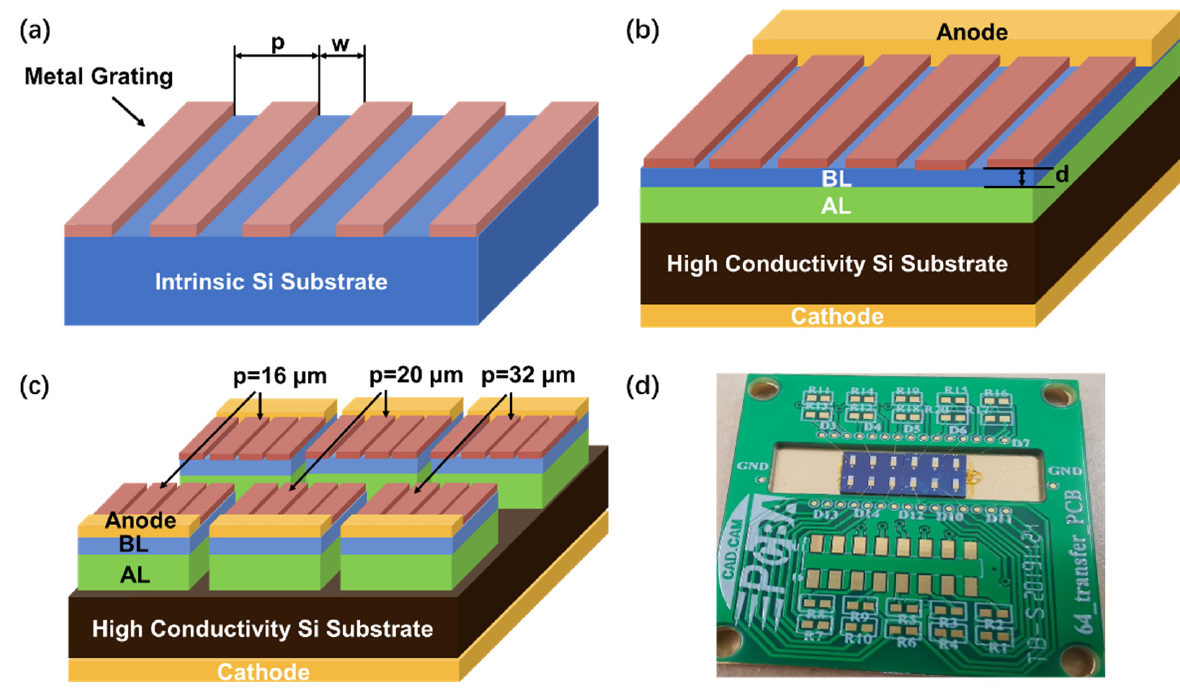
Figure 1. ( a ) Structure diagram of metal grating/Si (130 μ m), in which 𝑝 is the metal grating period; 𝑤 is the interval width between the metal strips; and the duty ratio, (cid:4666)𝑝 (cid:3398) 𝑤(cid:4667)/𝑝 , is fixed at 3/4. ( b ) Structure diagram of metal grating/Si-based BIB detector, in which 𝑑 is the thickness of the BL. ( c ) Structure diagram and ( d ) photo of 3 × 2 array multicolor metal grating/Si-based BIB detector.